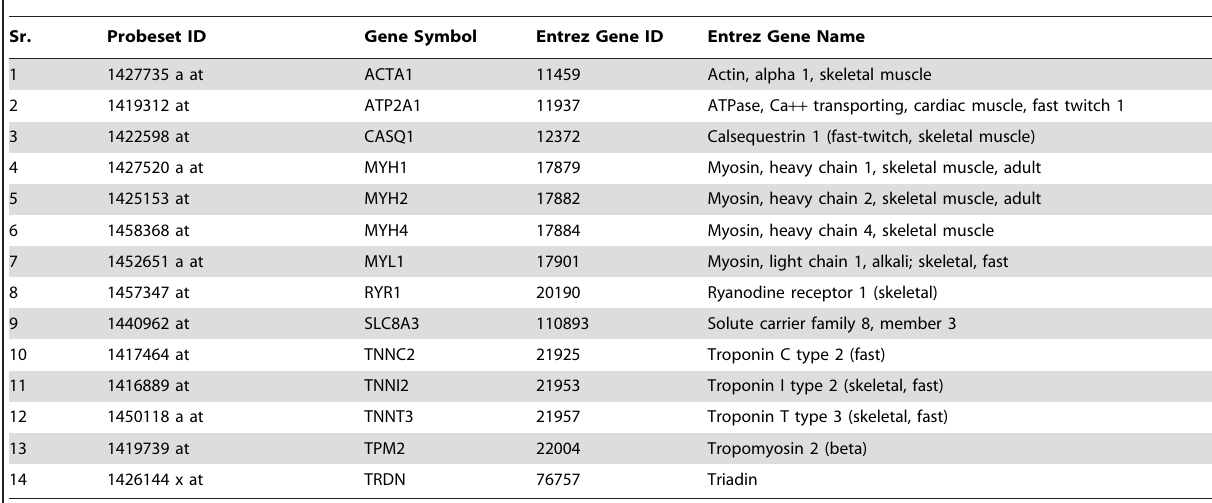
Table 7. Muscle genes present in the calcium signalling pathway.